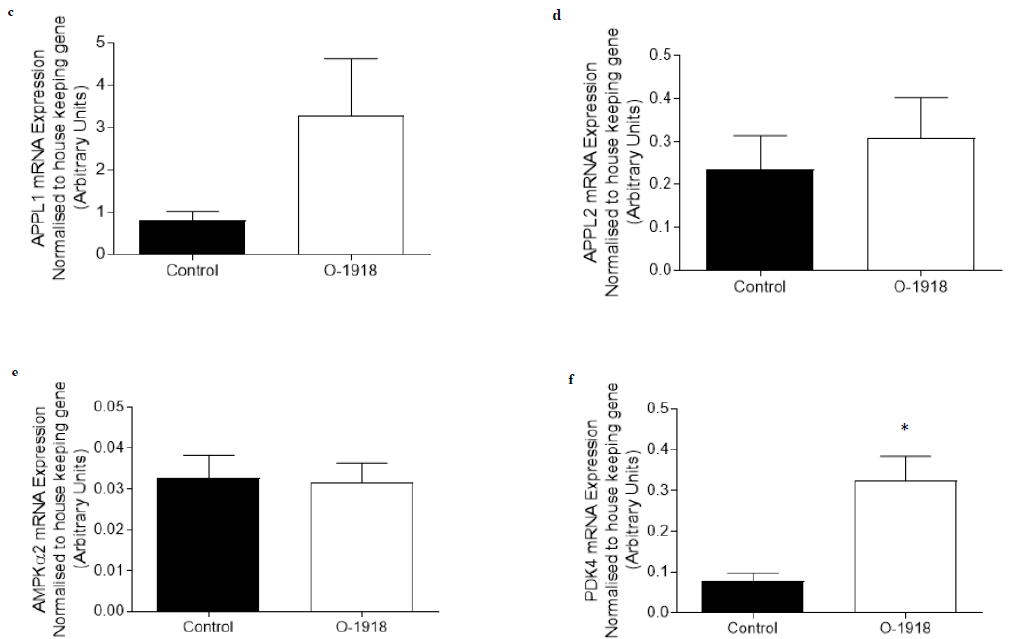
Figure 4. The abundance of mRNA expressed for markers involved in adiponectin signalling, fatty acid oxidation and oxidative capacity in C 2 C 12 myotubes treated for 24 h with O-1918 (100 nM). mRNA expression was normalised to housekeeping gene Hypoxanthine Phosphoribosyltransferase (HPRT1) and grouped data is reported as mean (arbitrary units) ± SEM (* significance p < 0.05). ( a ) Nuclear Factor of Activated T-Cells calcineurin dependent 1 (NFATc1); ( b ) Peroxisome proliferator-activated receptor gamma co activator 1-alpha (PGC1 α ); ( c ) Adaptor protein containing pleckstrin homology domain, phosphotyrosine binding domain and leucine zipper motif 1 (APPL1); ( d ) Adaptor protein containing pleckstrin homology domain, phosphotyrosine binding domain and leucine zipper motif 2 (APPL2); ( e ) Adenosine Monophosphate Kinase alpha 2 (AMPK α 2); ( f ) Pyruvate Dehydrogenase Kinase 4 (PDK4).